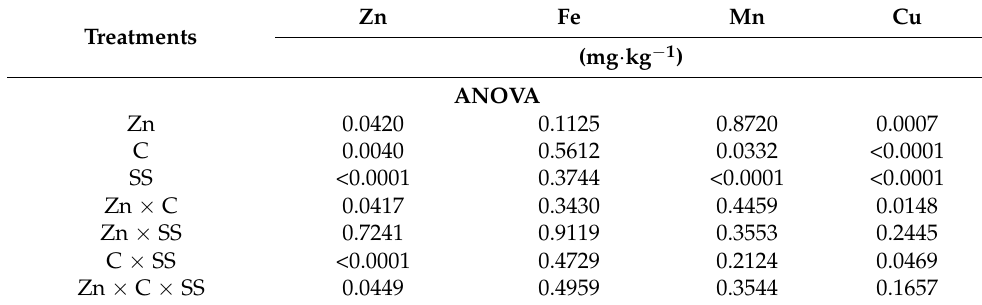
Table 2. Cont. Treatments